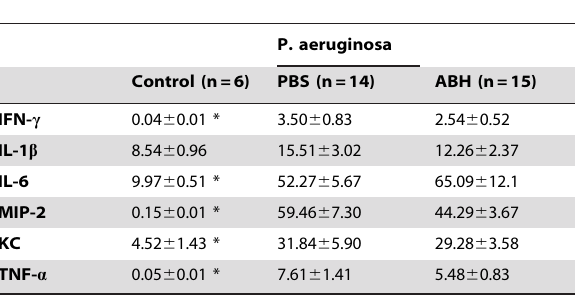
Table 2. Cytokine concentrations (ng/g) in lung homogenates of naı¨ve control and Pseudomonas infected mice treated with PBS or arginase inhibitor ABH.